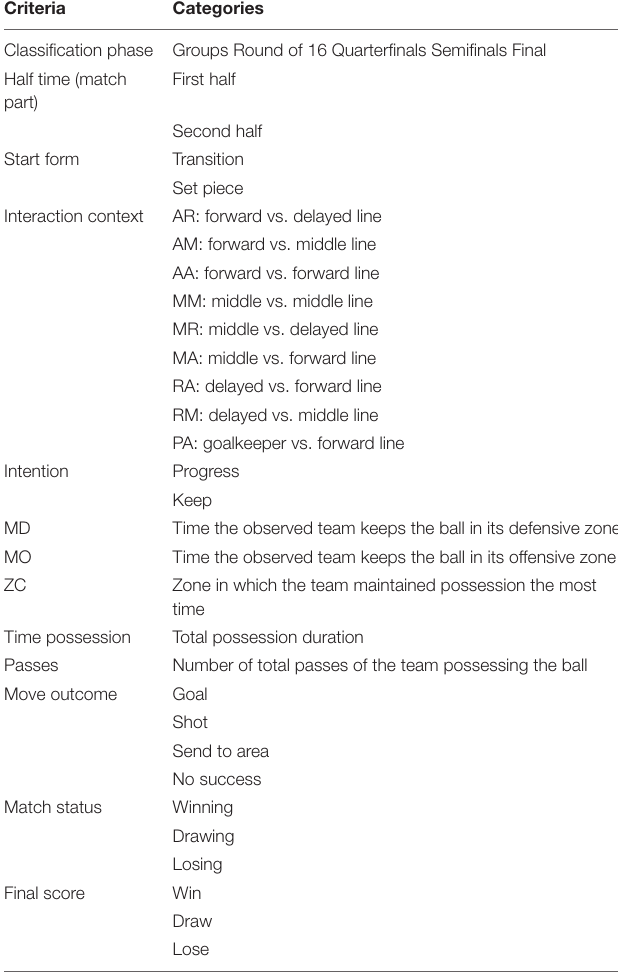
TABLE 1 | Dimensions that are part of the ad hoc instrument and derived category systems.